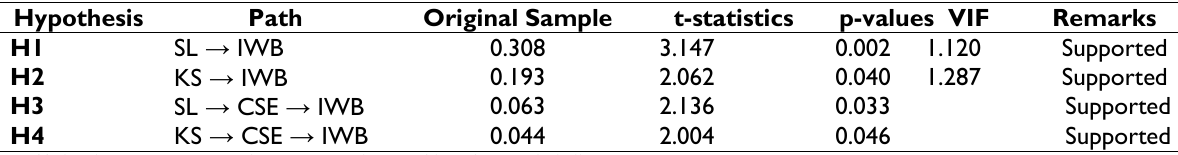
Table 5. The structural